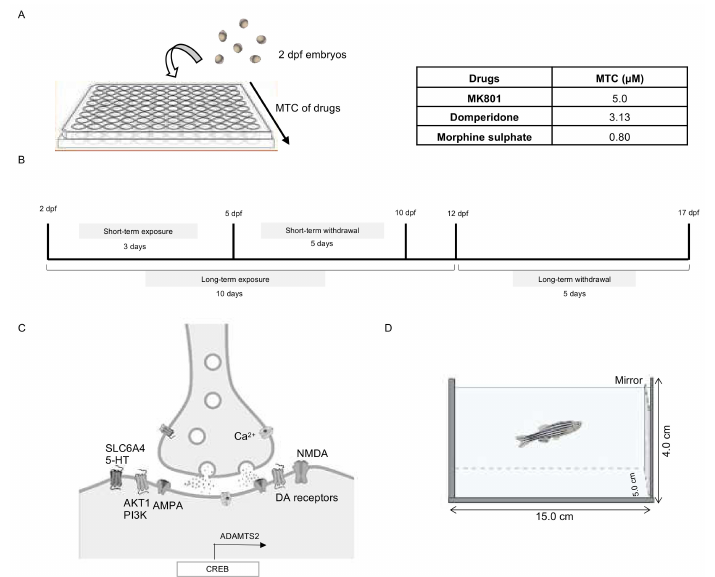
Figure 1. Experimental design schematics. ( A ) Embryos at 48 hpf were treated to obtain the MTC of the drugs. ( B ) Exposure timeline of the drugs. ( C ) Synaptic localization of all genes examined. ( D ) Aggression testing using a test tank with a mirror. ADAMTS2: a disintegrin and metalloproteinase with thrombospondin motifs 2, AKT1: v-akt murine thymoma viral oncogene homolog 1, AMPA: α -amino-3-hydroxy-5-methyl-4-isoxazolepropionic acid, CREB: cAMP responsive element binding protein, DA: dopamine, dpf: days post fertilization, hpf: hours post fertilization, MTC: maximum tolerated concentration, NMDA: N-methyl-D-aspartate, PI3K: phosphoinositide 3-kinase, SLC6A4: solute carrier family 6 member 4, 5-HT: